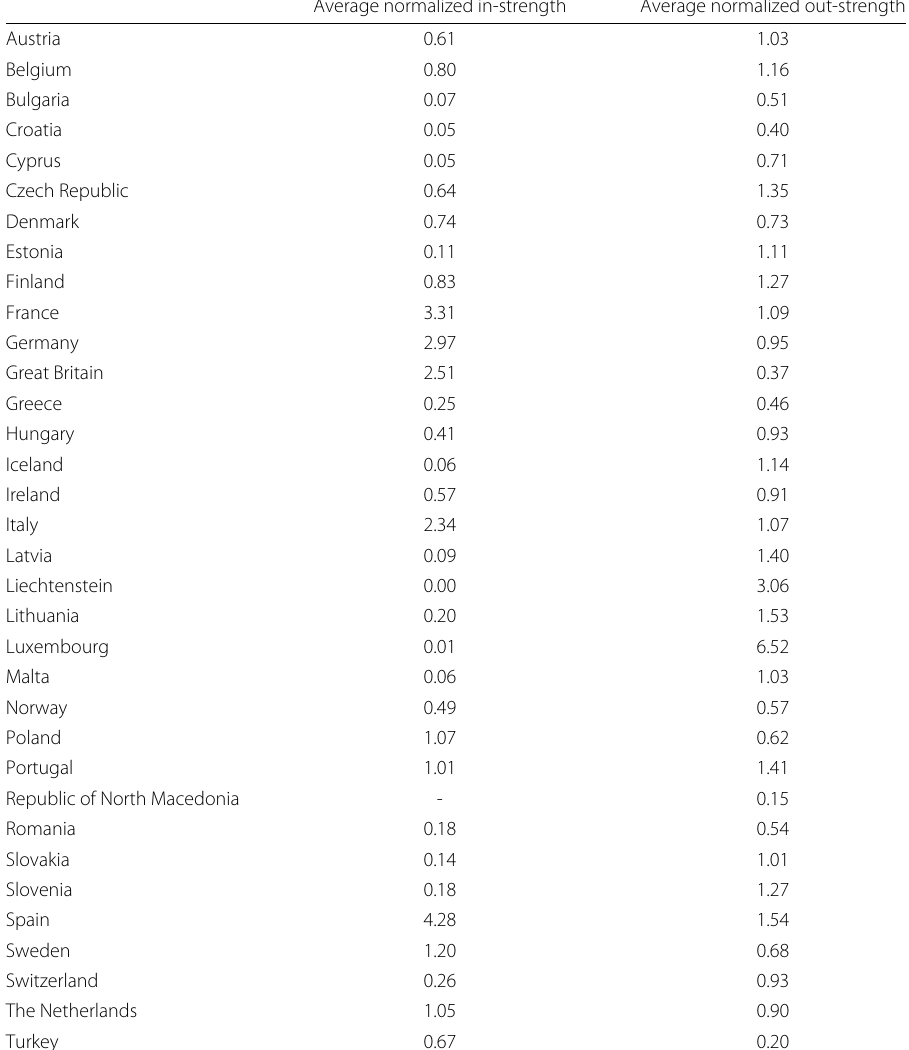
0.18 0.54 0.14 1.01 0.18 1.27 4.28 1.54 1.20 0.68 0.26 0.93 1.05 0.90 0.67